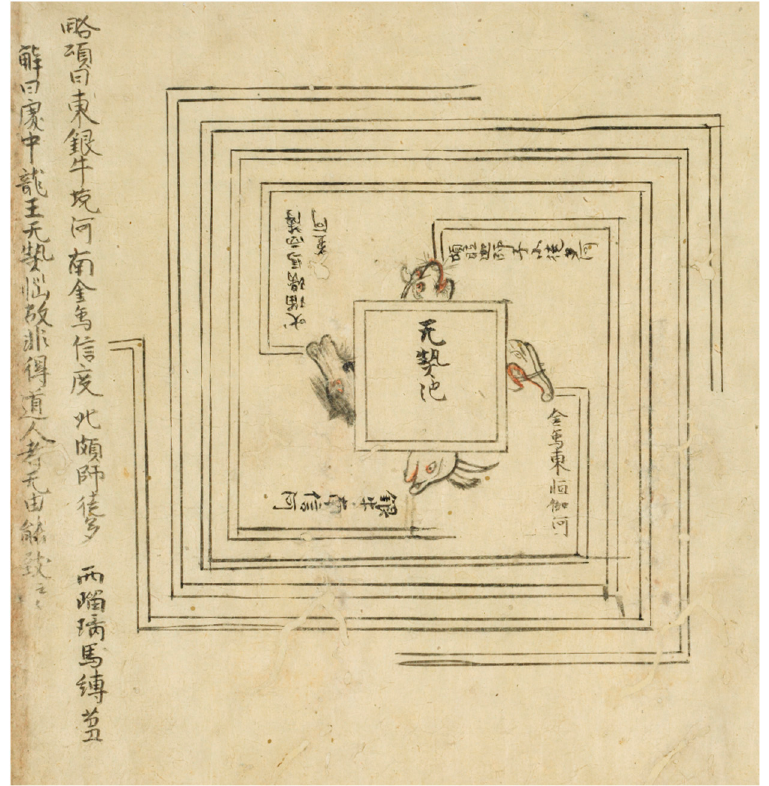
Figure 1. A diagram of the Anavatapta Lake from the Harvard scroll. Section from Buddhist Cosmology ( Nihon koku narabini Shumi shoten zu ) with text copied by Monk Ry ū i; Harvard Art Museums/Arthur M. Sackler Museum, Gift of the Hofer Collection of the Printed and Graphic; ©President and Fellows of Harvard College; Accession Number: 1973.66; Image Numbers: DDC101828.